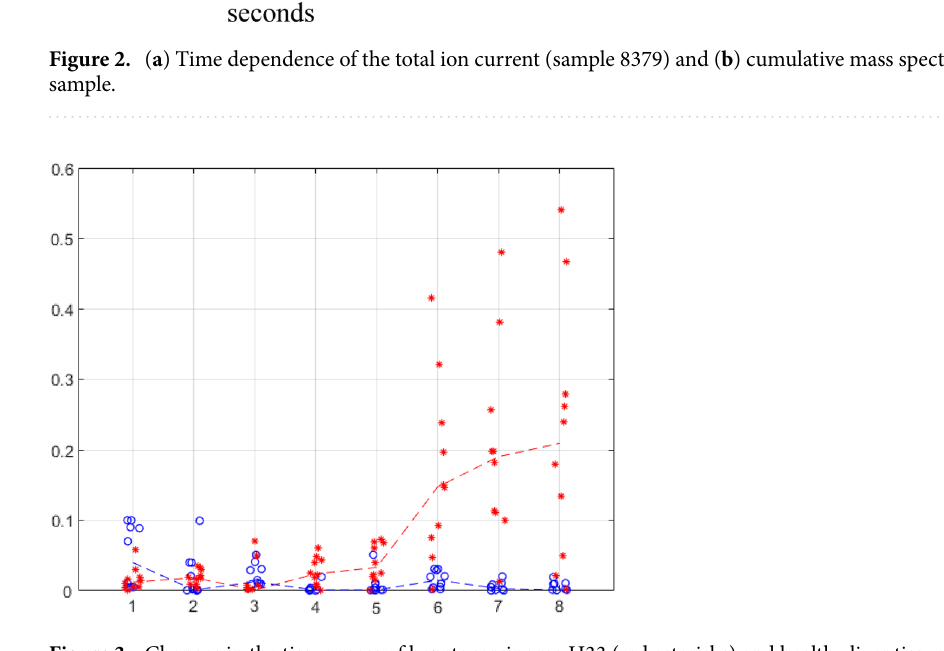
Figure 3. Changes in the tissue mass of hepatocarcinoma H33 (red asterisks) and healthy liver tissue (blue circles) by days after transplantation. The horizontal axis shows days after transplantation, and the vertical axis shows values of the mass of the altered tissue ("tumour") in grams. For clarity, the medians of the same type of mass measurements are connected by dashed